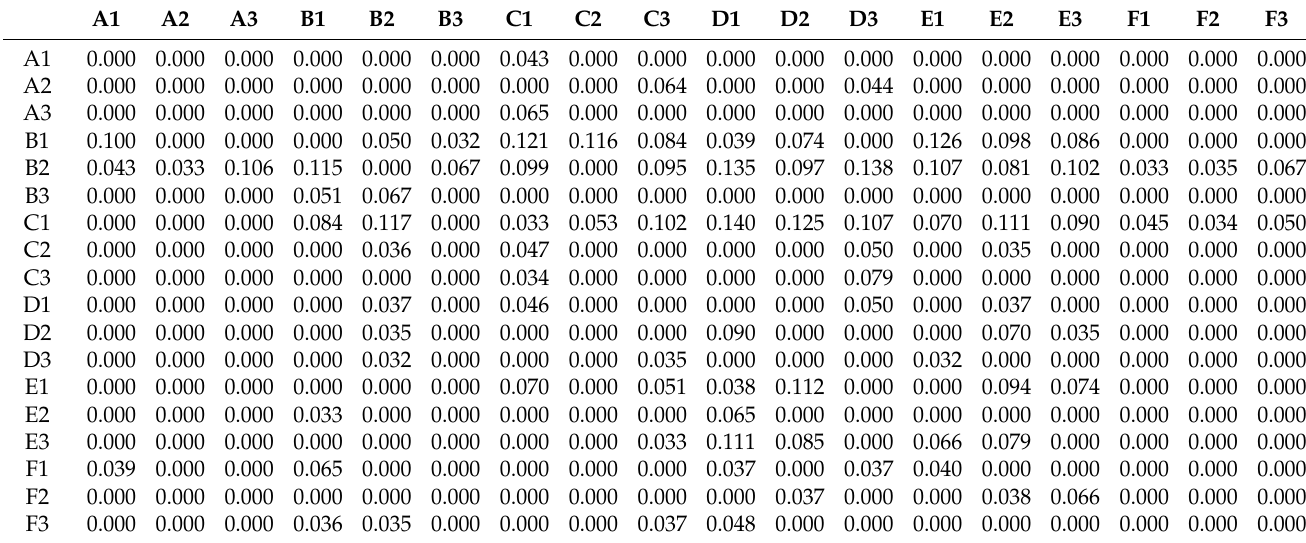
Table A1. The normalized total